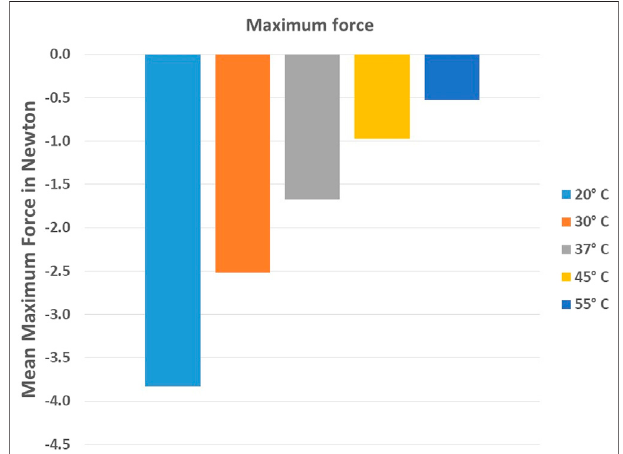
FIGURE6| Barchartshowingthemeanmaximumforcegeneratedona 2-mm vertical three-point bending testing of 3D-printed specimens of ClearX v.1.1 shape memory material at different temperatures.